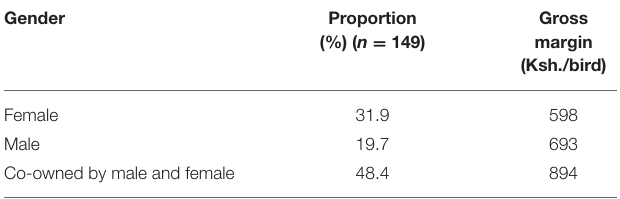
TABLE 7 | Gender of owner of indigenous chicken venture and